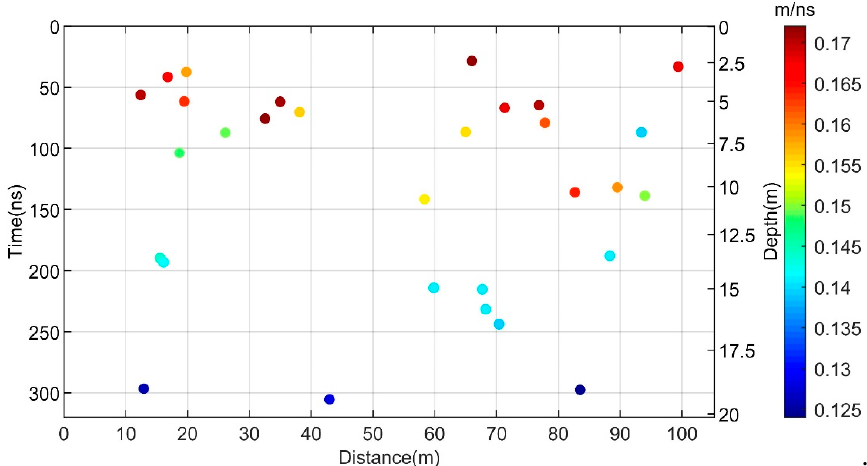
Figure 10. Velocity scatter figure.